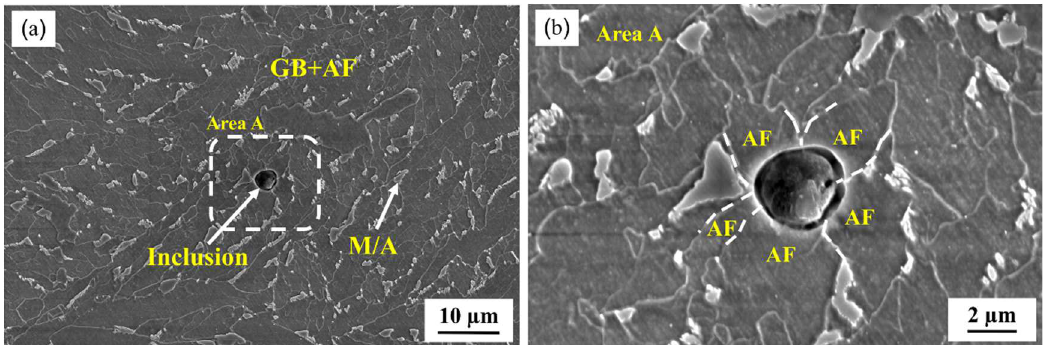
Figure 1. ( a ) Scanning electron microscopy microstructure of the CGHAZ., ( b ) morphology of the enlarged part in the white box in ( a ). (GB: granular bainite, AF: acicular ferrite, M/A: martensite—austenite constituents).